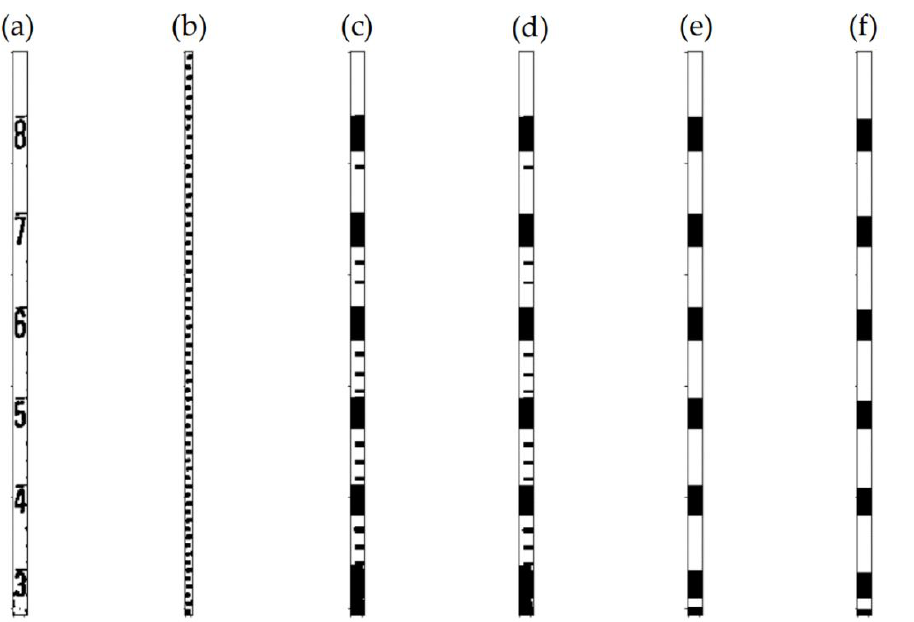
Figure 17. Further segmentation of characters and scale lines. ( a ) The image of the water ruler containing only one side of the array character area segmented from the image Figure 16c. ( b ) The image of the water ruler containing only one side of the scale lines area segmented from the image in Figure 16c. ( c ) The final four images ( c – f ) are obtained by morphological manipulation and projection from ( b ).